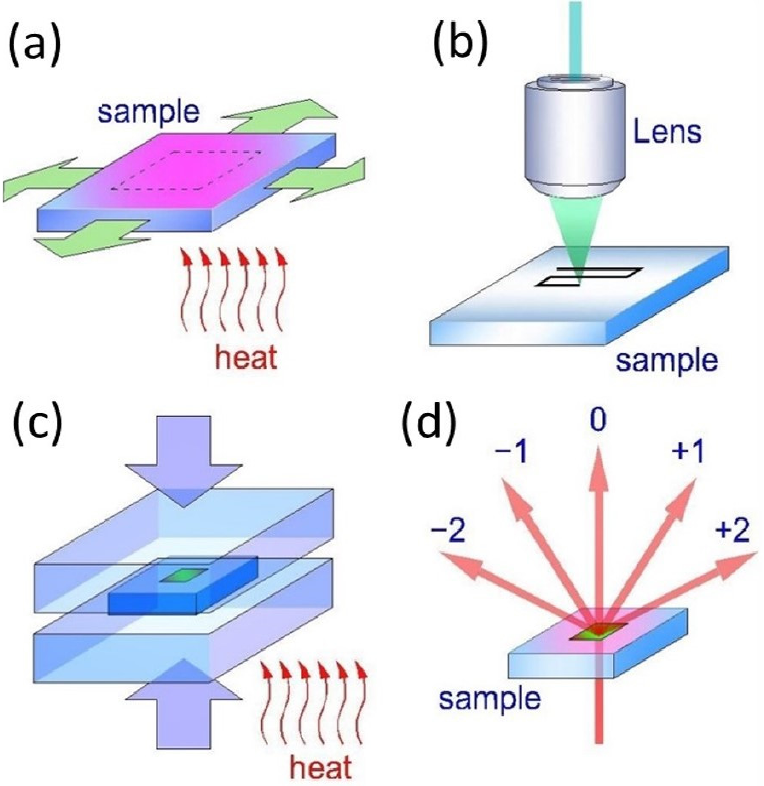
Figure 1. Three-step fabrication of sub-wavelength diffraction gratings in heat-shrinkable polymers: ( a ) pre-stretching of the thermoplastic sheet; ( b ) laser inscription of diffraction micro-grating; ( c ) controllable heat-shrinking down to nanoscale dimensions; ( d ) diffraction test of the downscaled grating.